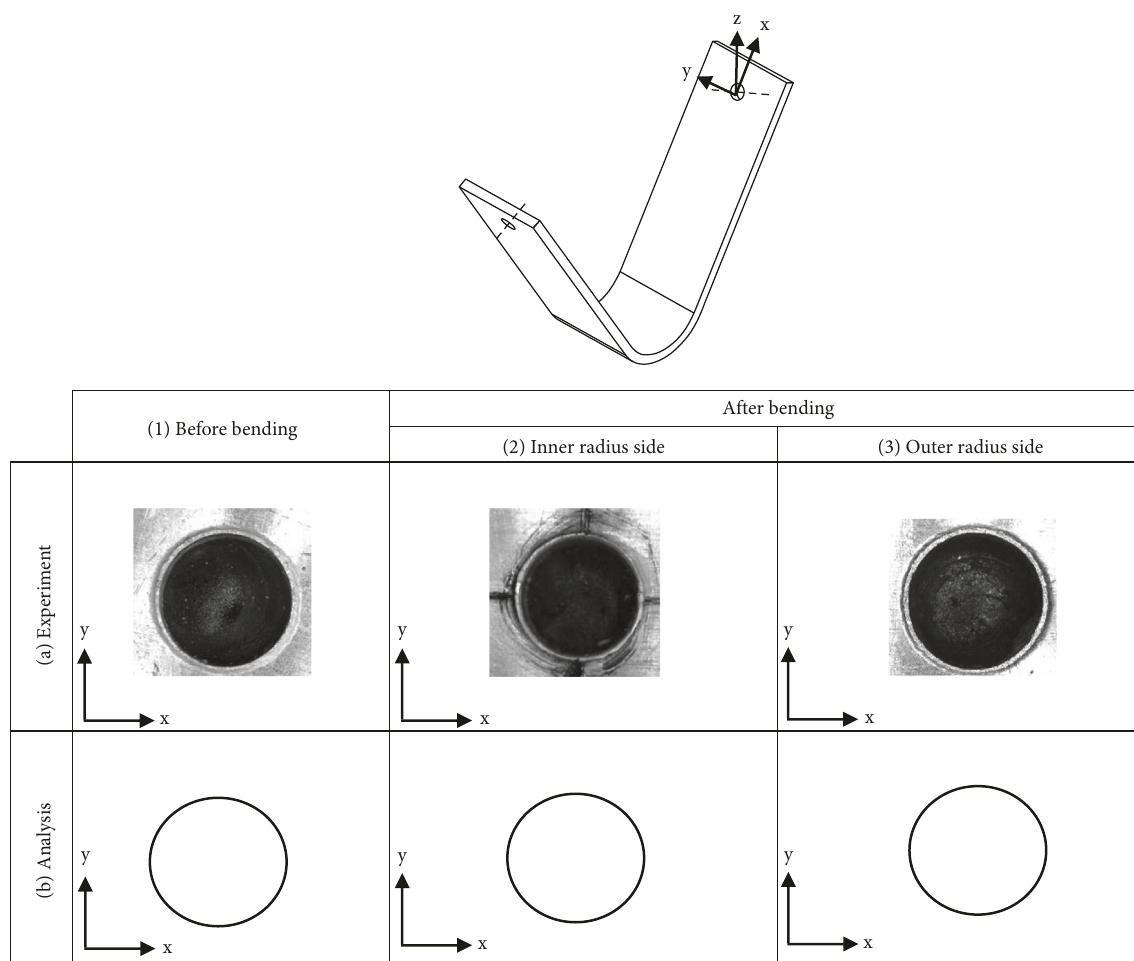
Figure 7: Illustration of plastic deformation and stress analysis on hole in the case of hole located at leg zone (hole diameter: 5mm, bend angle: 60 ° ). (a) Experiment. (b)